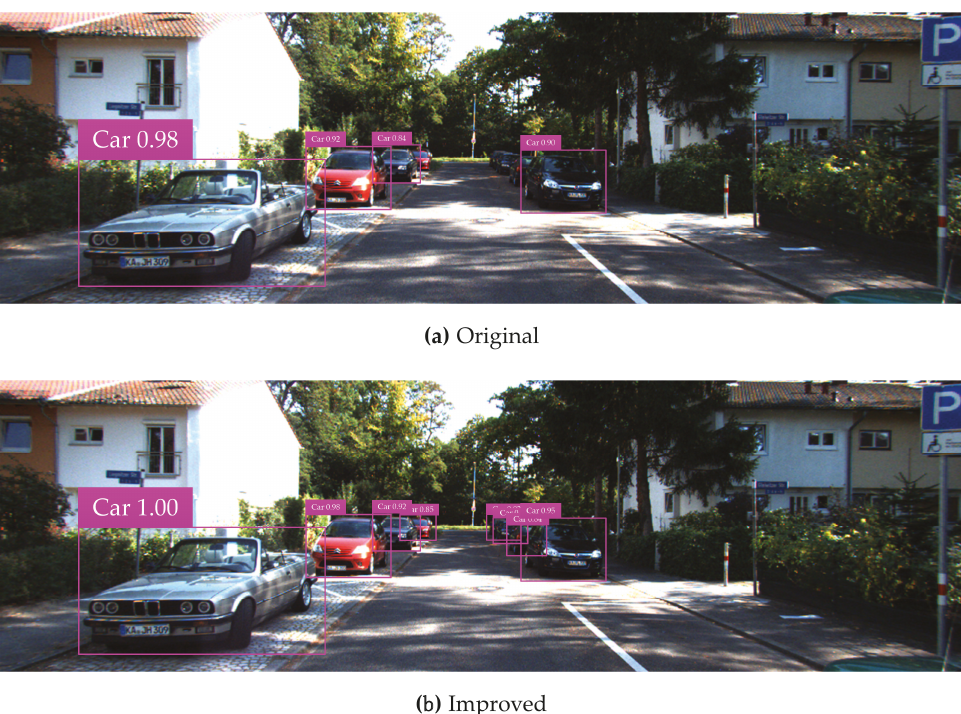
Figure 8. Vehicle detection test results in the shadow environment based on the original and improved